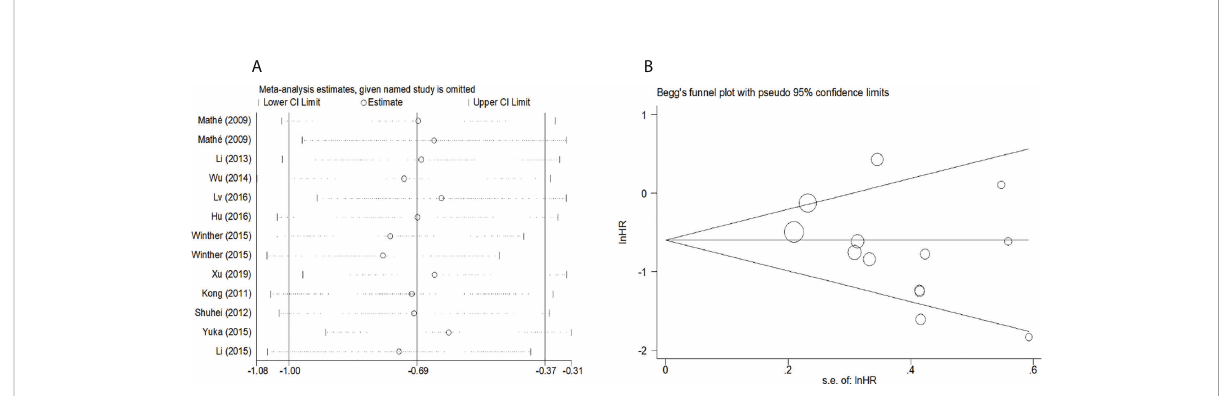
FIGURE 5 (A) Sensitivity analysis for meta-analysis of mir-375. (B) Funnel plots of publication bias for meta-analysis of mir-375.